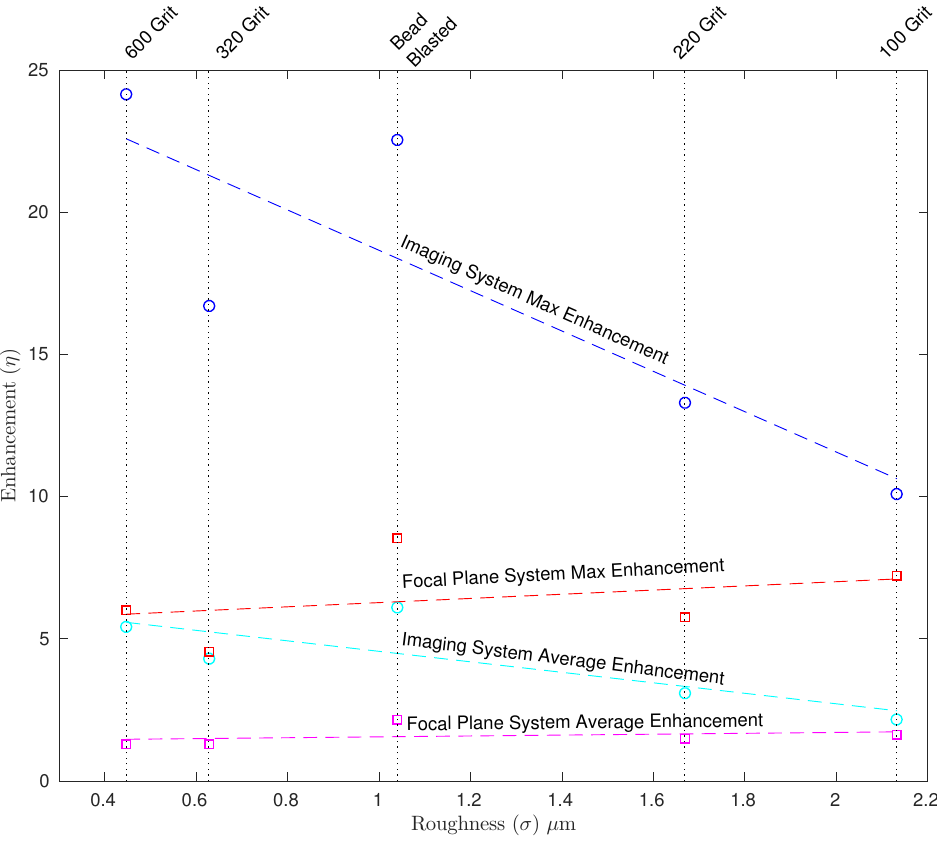
Figure 3. Enhancement ( η ) vs. Surface Roughness ( σ ). The surface roughness measured by the Tencor profilometer is plotted with enhancement. Linear trend lines are included. For the focal-plane system, maximum enhancement is shown in red, while average enhancement is shown in magenta. For the imaging system, maximum enhancement is shown in blue, while average enhancement is shown in